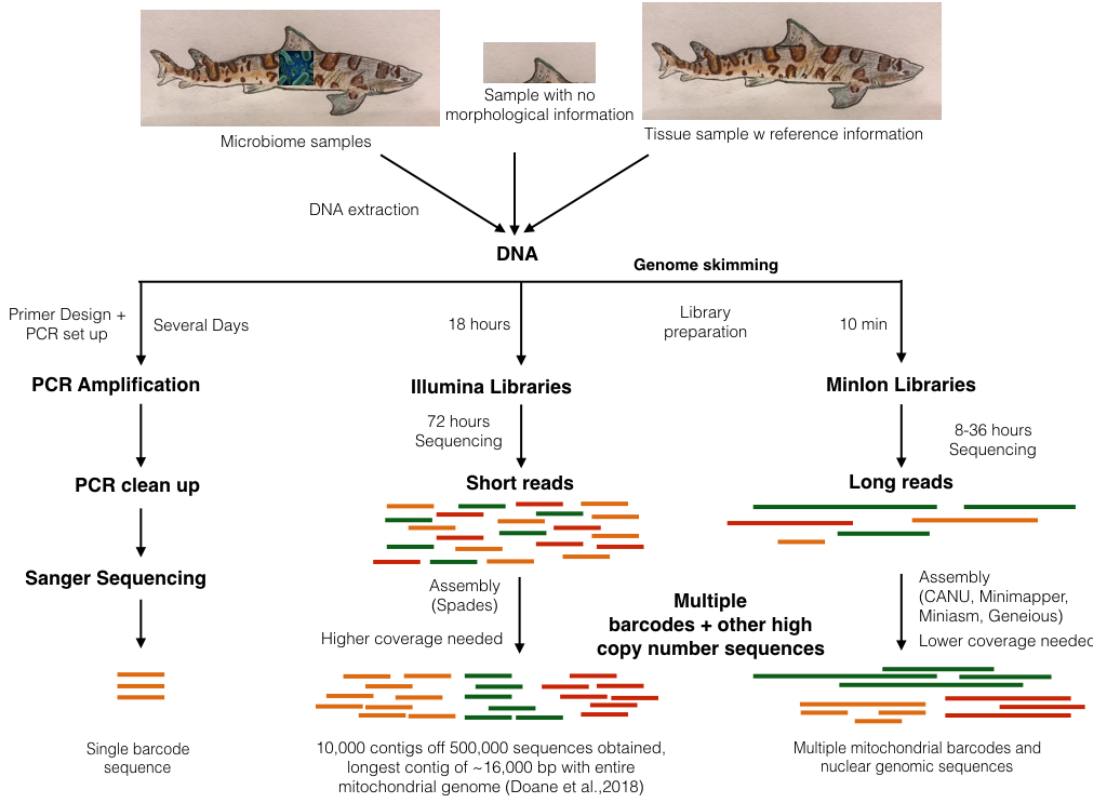
Figure 1. Comparison of sequence data obtained with Genome skimming and PCR-based approaches.